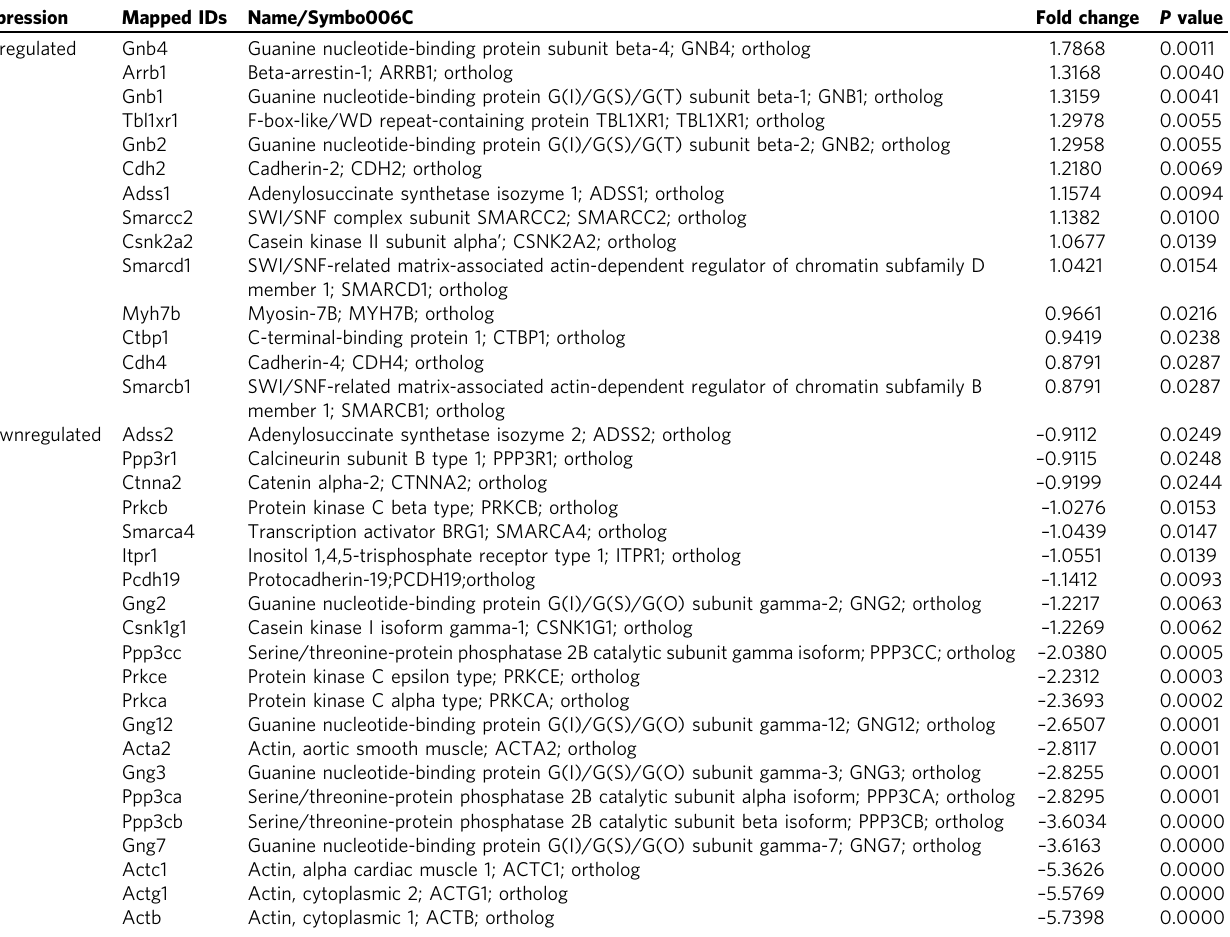
Table 1 DEPs in THRSP KO mice involved in Wnt signaling. Expression Mapped IDs Name/Symbo006C